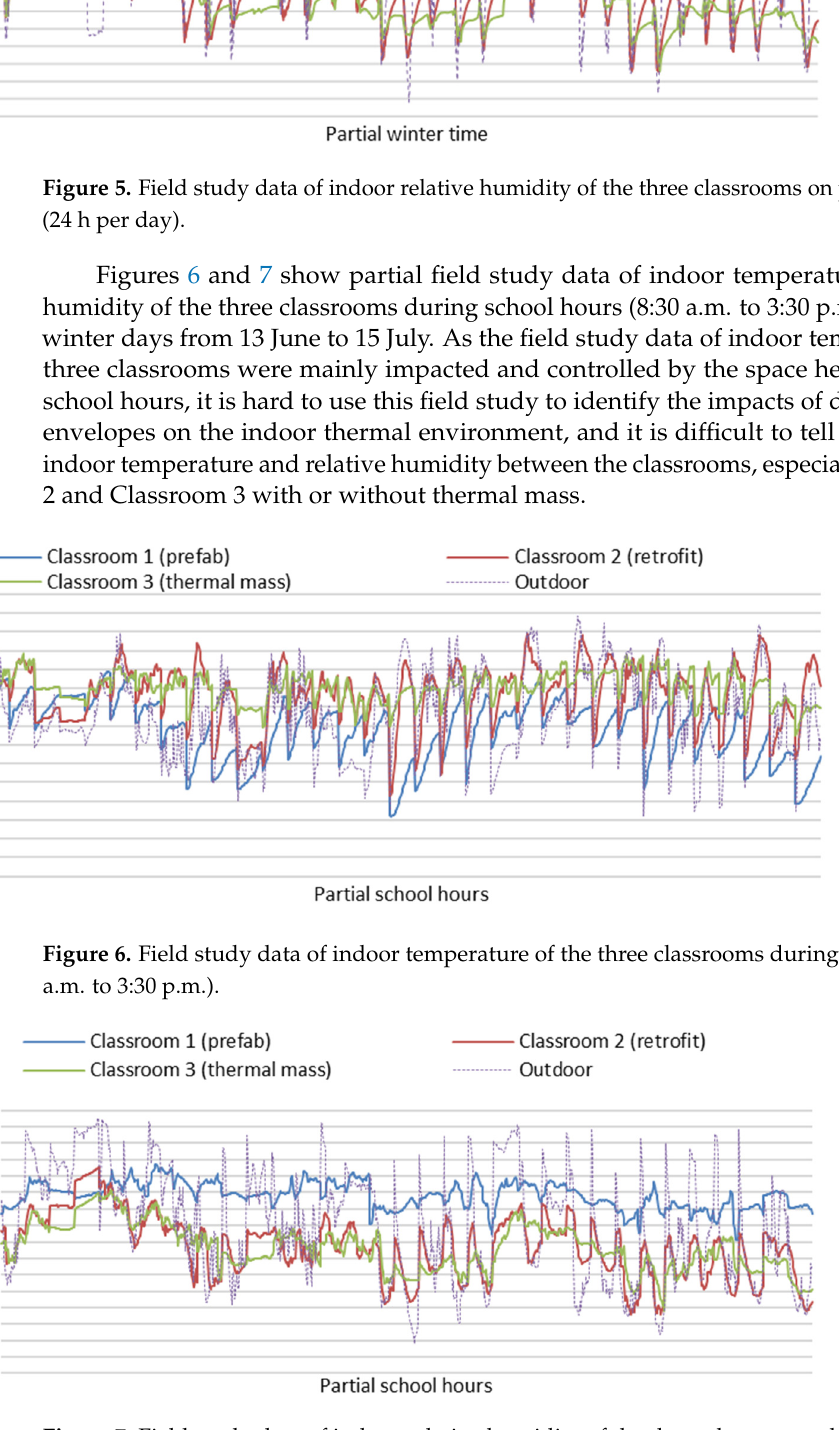
Figure 5. Field study data of indoor relative humidity of the three classrooms on partial winter days (24 h per day).